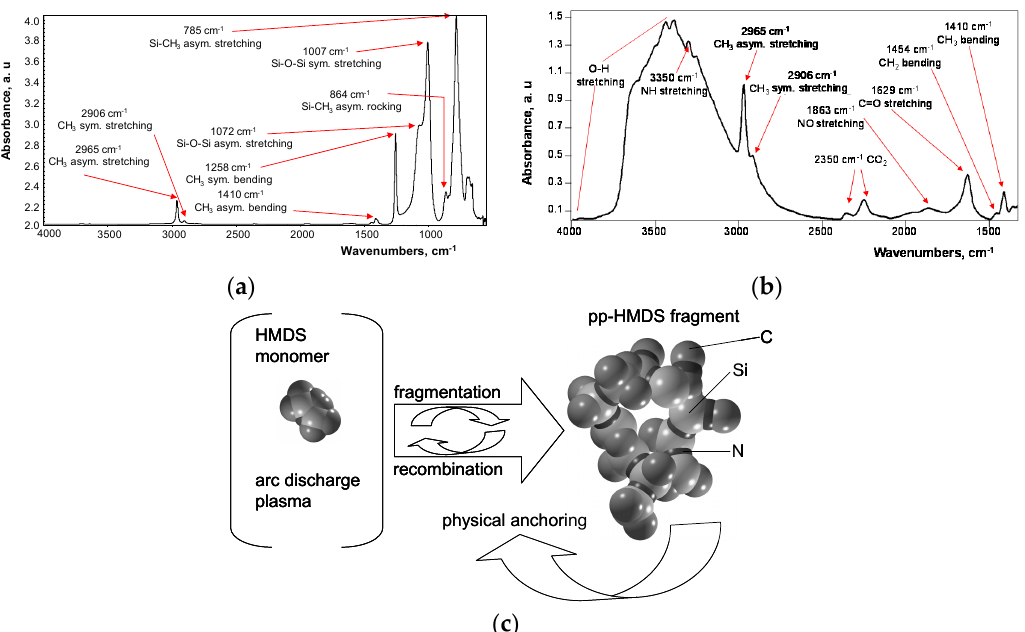
Figure 3. FTIR absorbance spectra of flexible PDMS substrate ( a ) and pp-HMDS ( b ) with functional groups assigned and schematic diagram of probable deposition mechanism ( c ); HMDS monomer and pp-HMDS network fragment are shown in van der Waal’s-based